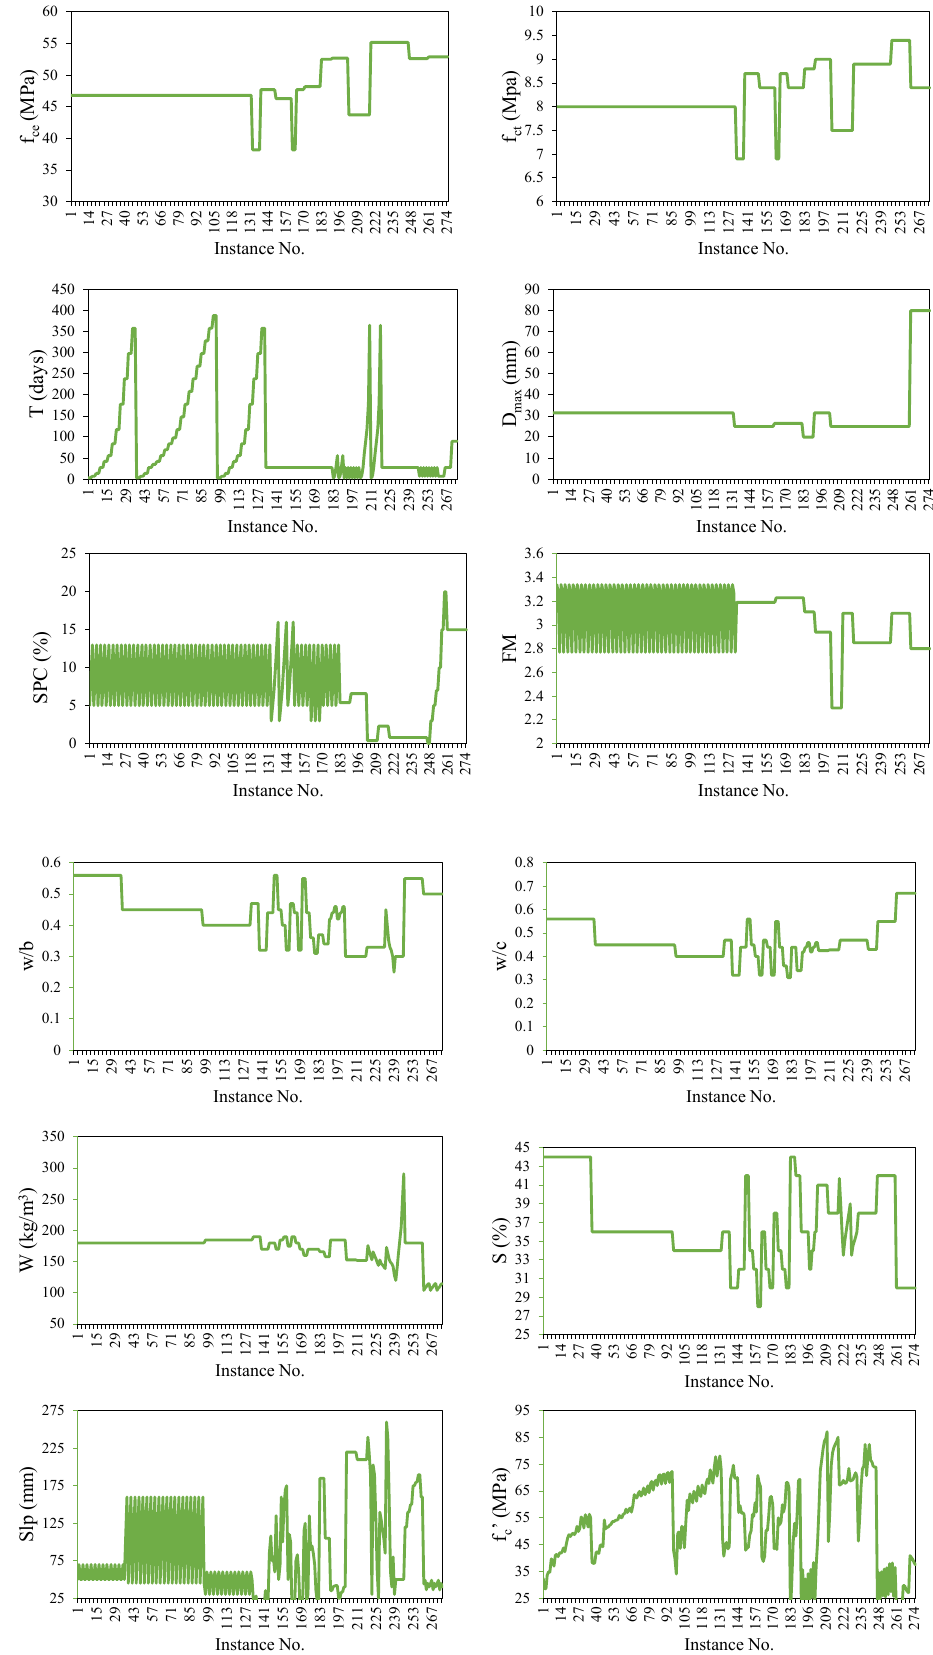
Figure 1. Details of variables used in the development of models.